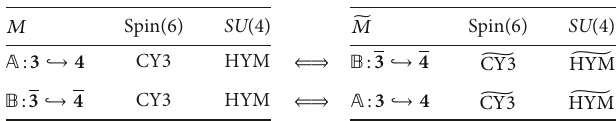
Figure 1: Mirror